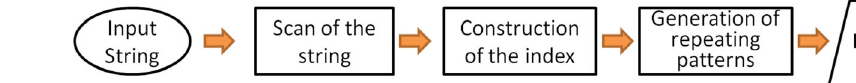
Fig. 1 Workflow of the proposed method